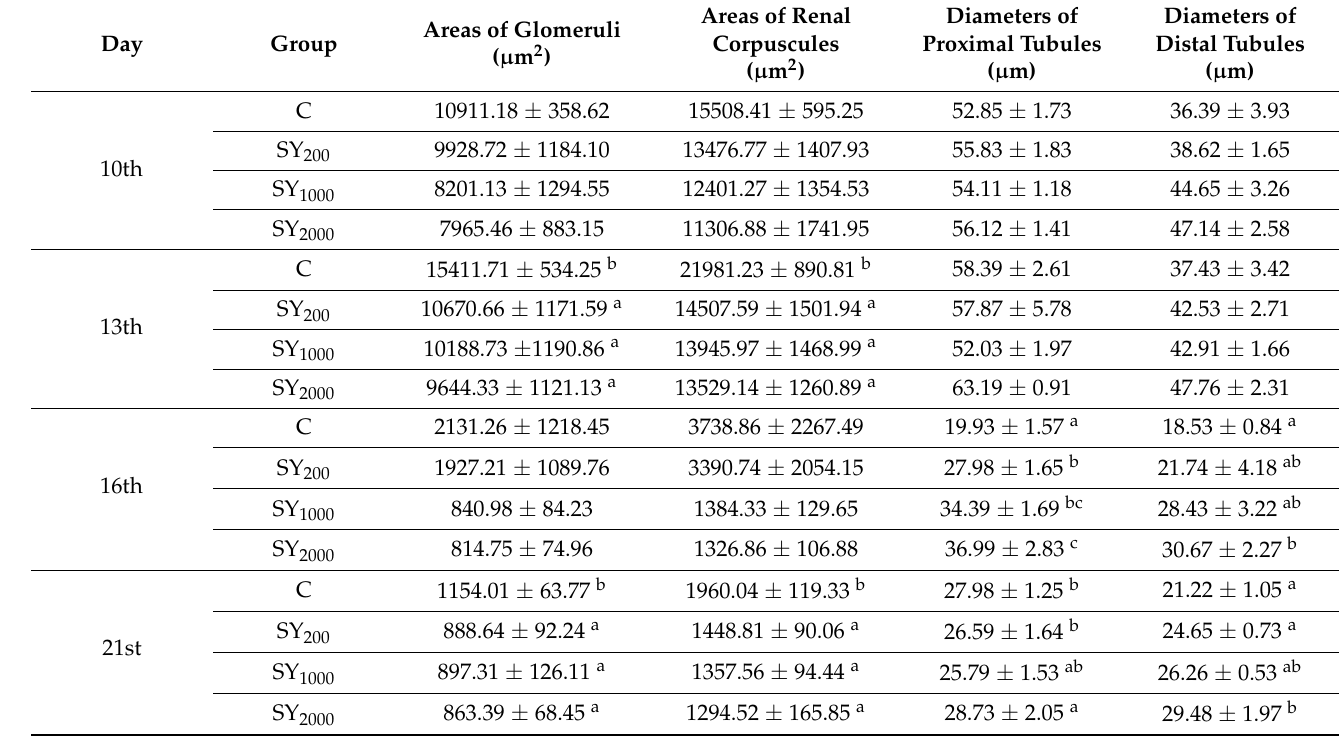
Table 3. The measurements of areas and diameters in the kidney structures (Mean ±